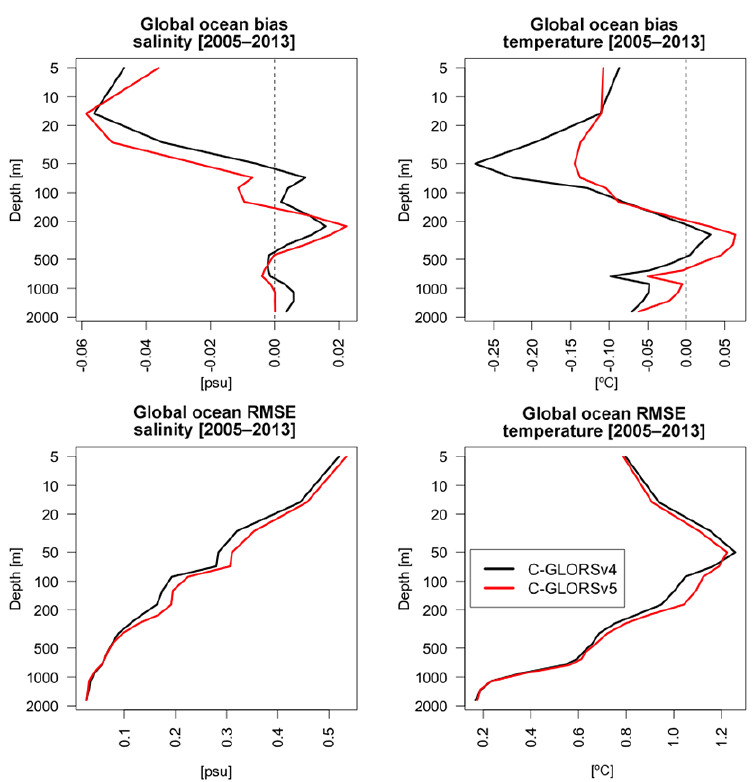
Figure 5. Verification skill scores (bias and RMSE) of C-GLORSv4 and C-GLORSv5 against Argo floats from EN4 over the period 2005– 2013 as a function of ocean depth. Units are psu and degrees Celsius for salinity and temperature, respectively. Bias is defined as observation minus model